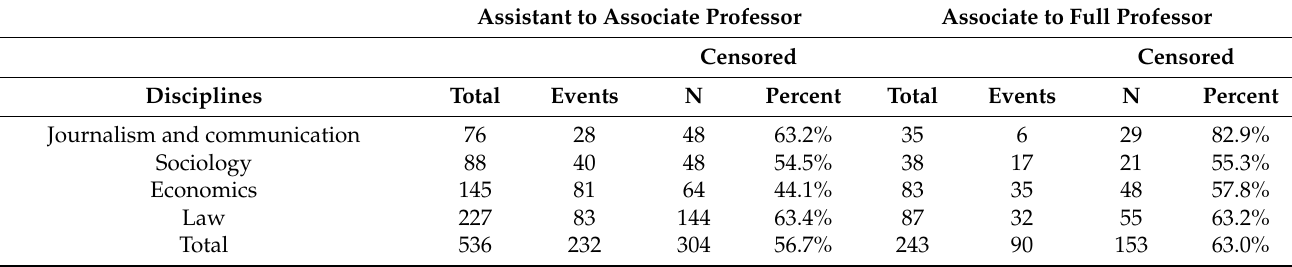
Table 1. Proportion of Each